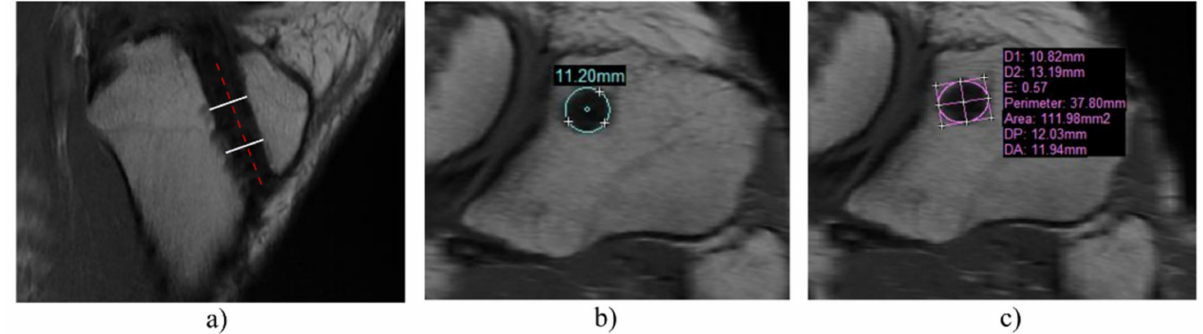
Figure 3. The method of measuring the bone tunnel: ( a ) the tunnel was divided into three parts, ( b ) the largest diameter of the circle was determined, and ( c ) the tunnel area was